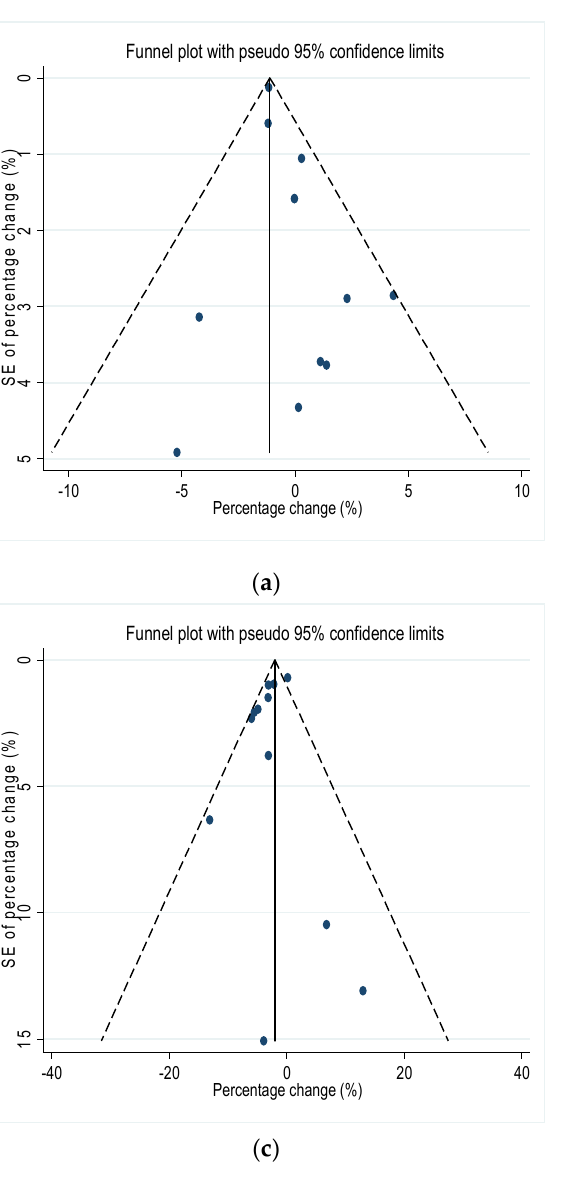
Figure 4. Funnel plot of the effects of short-term O 3 exposure and HRV indicators. ( a ) SDNN ( b ) RMSSD ( c ) HF ( d ) LF. The ordinate axis in funnel plot represents standard error (SE) of percentage change (%).